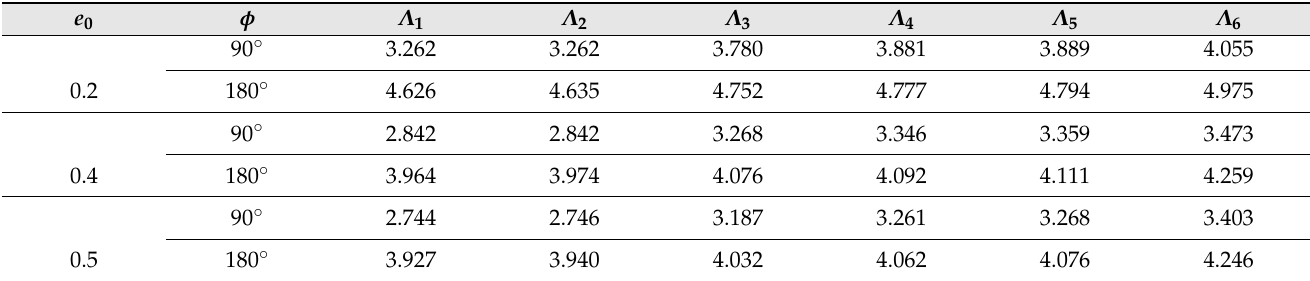
Table 6. Buckling loads (GPa) of FG-GPL, porous spherical caps for various polar angles and porosity coefficients (PD1, γ = 0.01 wt%,